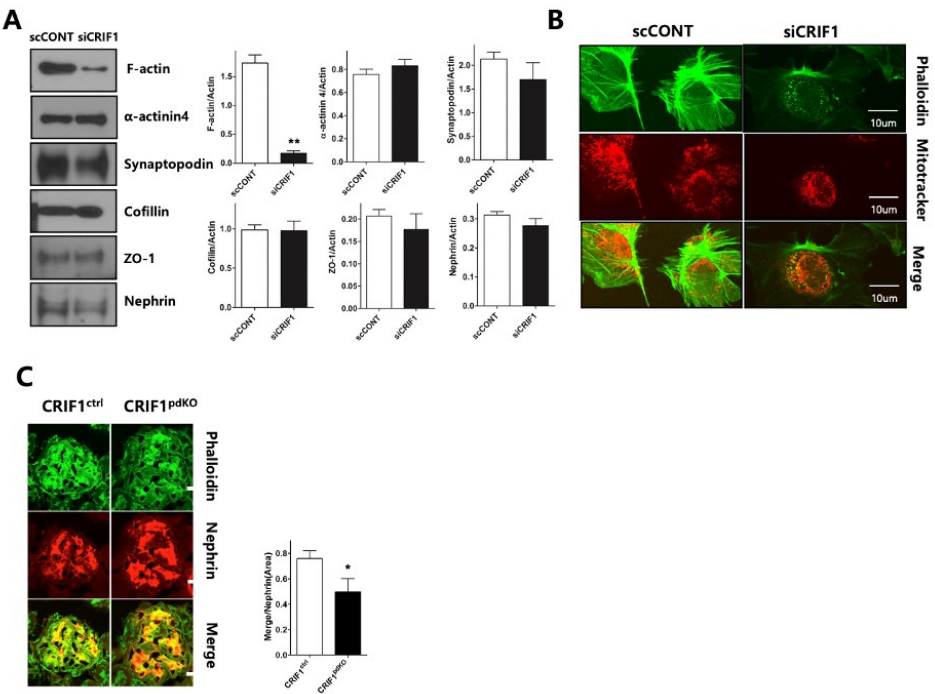
Figure 6. Deletion of CRIF1 causes loss and aggregation of F-actin in podocytes. ( A ) Immunoblot analyses of F-actin, α –actinin-4, synaptopodin, cofilin, ZO-1, and nephrin in control siRNA- and CIRF1-specific siRNA-transfected podocytes. Data are represented as the mean ± SD of n = triple replicates. ( B ) Immunofluorescent staining of phalloidin (F-actin) in control siRNA- and CIRF1-specific siRNA-transfected podocytes. Mitochondria were stained using MitoTracker Red. ( C ) Immunofluorescent staining of phalloidin (F-actin) and nephrin in kidneys from 10-week-old CRIF1 ctrl and CRIF1 pdKO mice. * p < 0.05, ** p < 0.01 by Student’s t -tests.